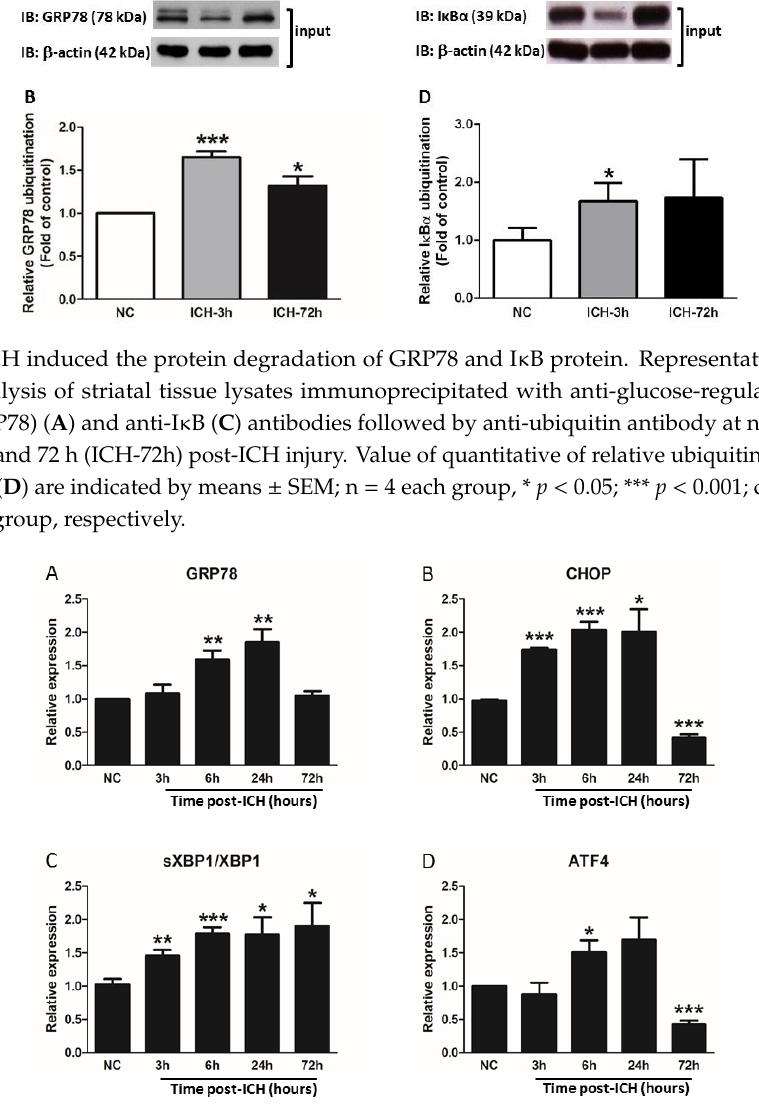
Figure 7. The mRNA expression of GRP78, CHOP, sXBP1 / XBP1 ratio, and ATF4 in ipsilateral striatum. The RT-qPCR measured the mRNA levels for GRP78 ( A ), CHOP ( B ), sXBP1 / XBP1 ( C ), and ATF4 ( D ) in the ipsilateral striatum at normal control (NC), 3 h, 6 h, 24 h, and 72 h post-ICH injury. Values are indicated by means ± SEM; n = 6 each group, * p < 0.05; ** p < 0.01; *** p < 0.001; compared to the normal control group, respectively.